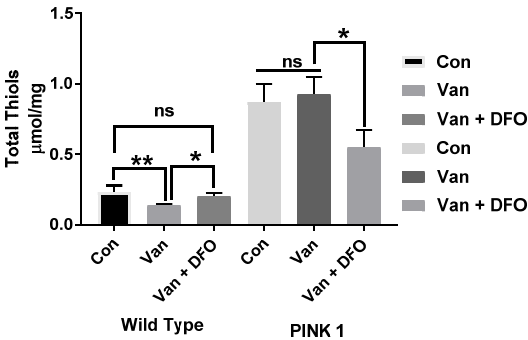
Figure 6. The influence of iron chelation following the chronic exposure of Drosophila melanogaster (WT and PINK-1 mutant) to low-dose vanadium upon the total thiol (T-SH) levels (after day 14). Influence of iron chelator T-SH levels in wild-type flies is lower than with those seen in PINK-1 mutant flies. Vanadium elicited a reduction in T-SH in WT flies but no significant e ff ect upon PINK-1 flies. Iron chelation (DFO) reverses the e ff ect of vanadium on T-SH levels in the WT fly to control levels (* p < 0.05) and significantly reduced the T-SH levels in PINK-1 flies (* p < 0.05) compared to the control and vanadium-treated PINK-1 flies. All values are from 5 separate experiments; n = 10 flies for each individual experiment, analysed with a repeated measure two-way ANOVA. * p < 0.05. ** p < 0.01, ns not significant